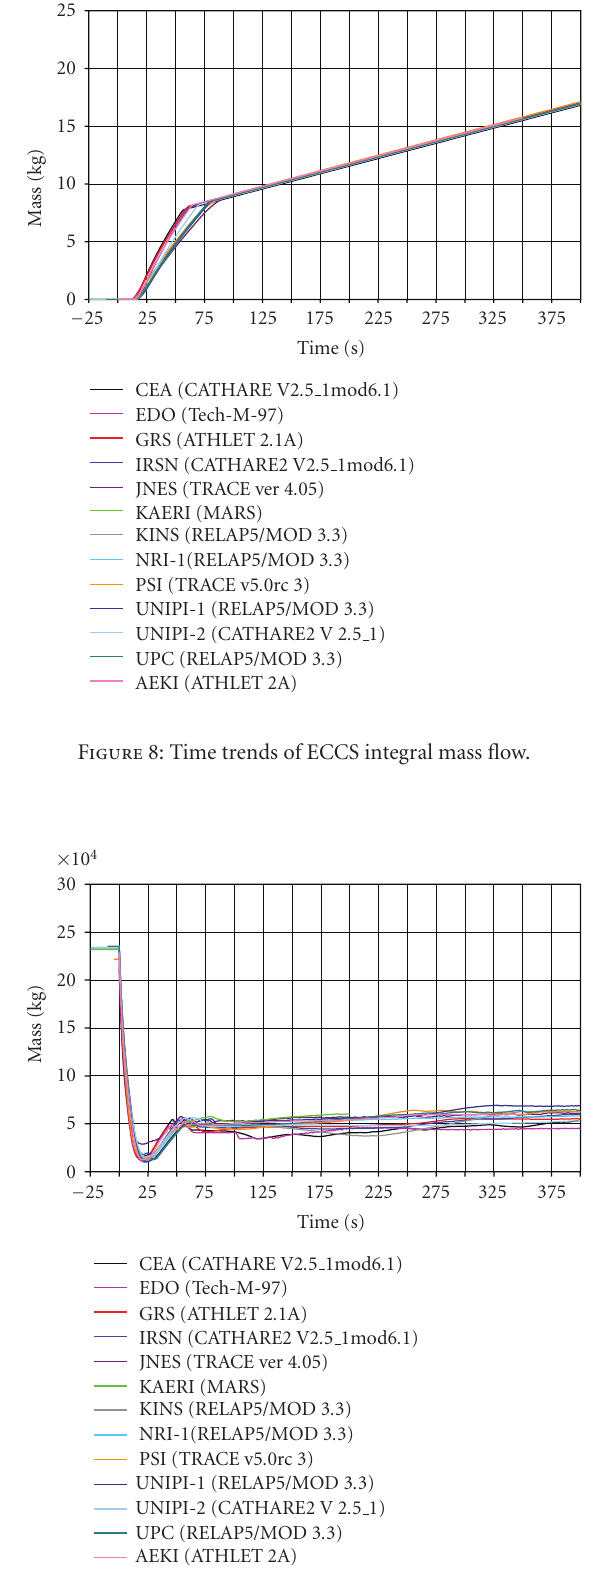
Figure 9: Time trends of primary system mass (including pressur- izer).